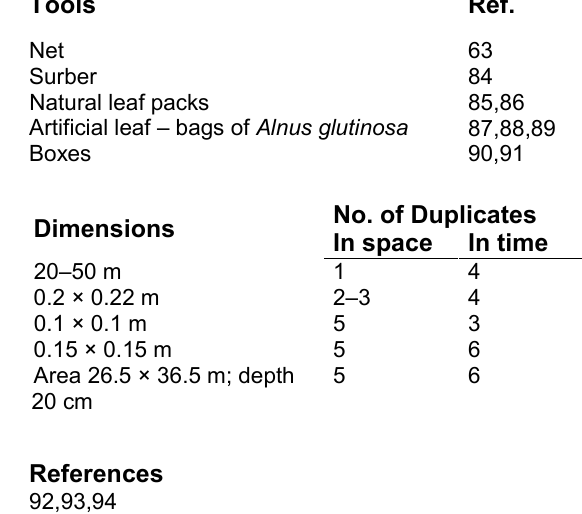
Inquiries on Macrobenthos Referring to the Method Used, Number of Duplicate Samples, and Laboratory